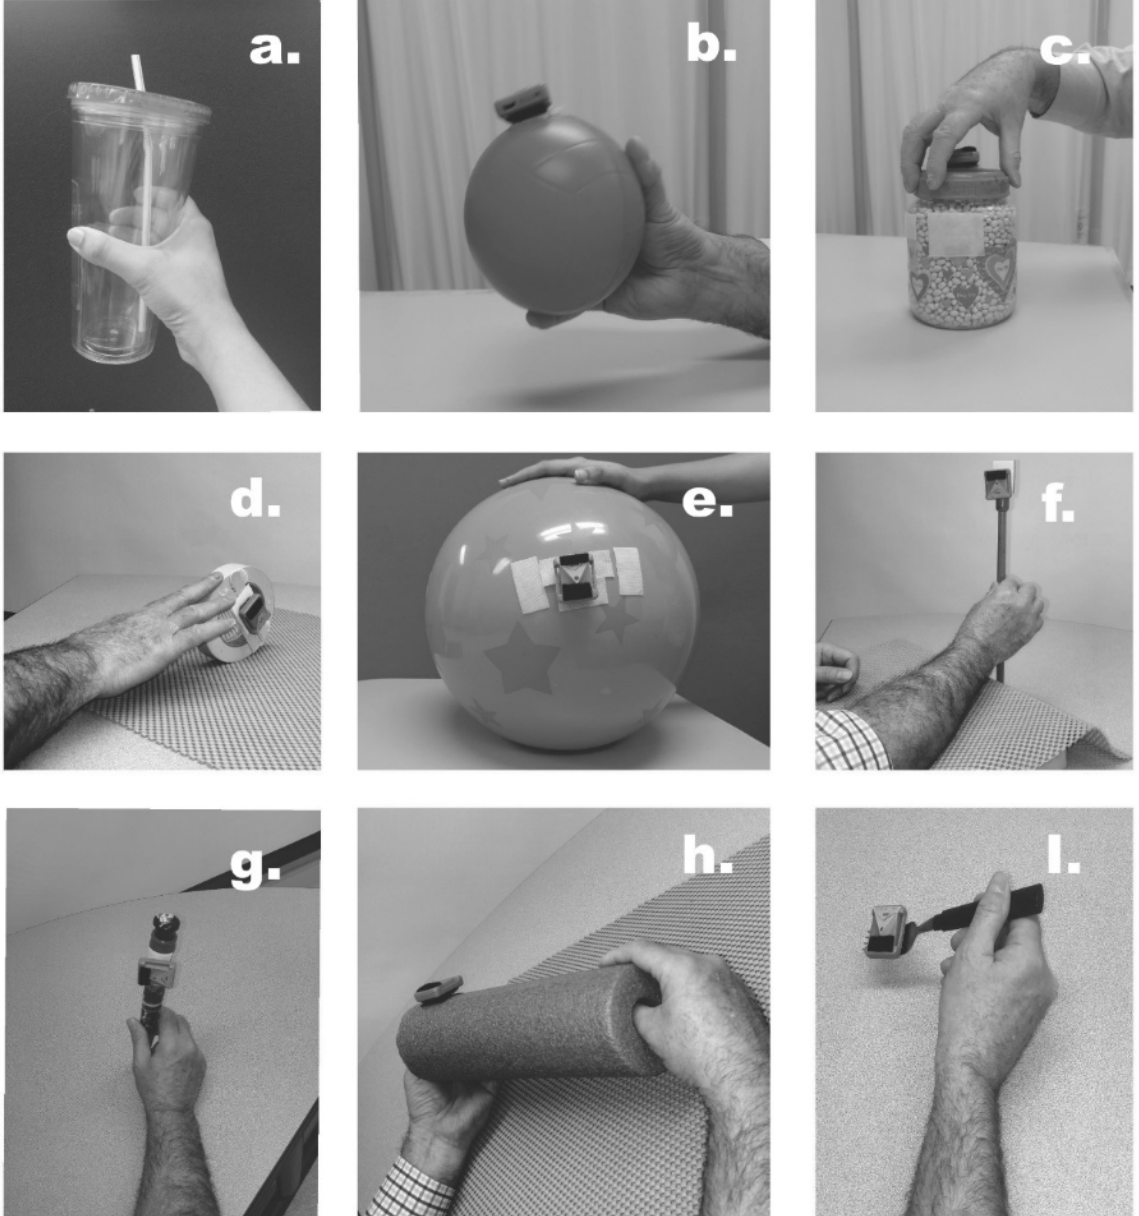
Figure 1. Example object manipulation tasks illustrated by a therapist: (A) handling a plastic cup with wrist radioulnar deviation while a midprone forearm is maintained with elbow resting on a surface; (B) handling a sponge ball (12-cm diameter) using wrist flexion- extension while maintaining a palmar grasp and midprone forearm with elbow resting on a surface; (C) rotation of a jar lid (opening and closing) using a 5-finger grasp over the lid and wrist radioulnar deviation and 5-finger flexion-extension with elbow resting on an elevated surface; (D) rolling movement of a toy wheel, manipulated using the index and middle fingertips and moved using shoulder flexion-extension; (E) bimanual beach ball manipulation using open hands and elbow flexion-extension for movement while forearms are maintained in a midprone position and shoulders maintained in mild flexion; (F) rolling a stick using index and middle fingertips and thumb opposition, while maintaining a neutral wrist and midprone forearm with elbow resting on an elevated surface; (G) manipulating a pen with index and middle fingers and thumb opposition using a tripod grip and maintaining a neutral wrist resting on the table; (H) bimanual roll of a pool noodle using thumbs and finger flexion-extension and fingertips for manipulation while a midprone forearm is maintained with elbow resting on a surface; (I) fork manipulation using a tip-to-pad grip with the index and middle finger, thumb opposition, and forearm supination-pronation with elbow resting on an elevated